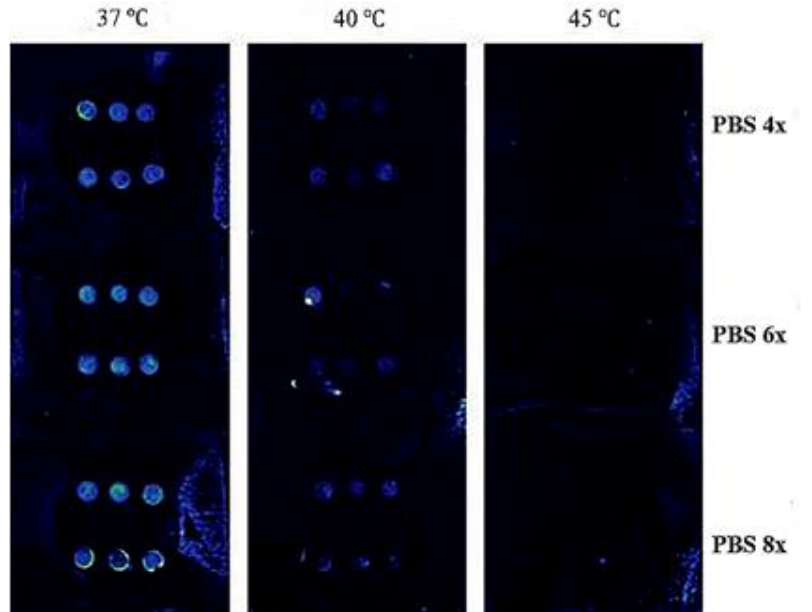
Figure 6. Inverted micrographs of HeLa cells grown in the absence and presence of the oligosiloxane modified thiophenes. Panels A and D are control after 18 h and 7 days, respectively. Panels B and E are poly(VI)-co-poly(3-methylthiophene) (50/50, w / w ), after 18 h and 7 days, respectively. Panels C and F are poly(VII)-co-poly(3-methylthiophene) (50/50, w / w ), after 18 h and 7 days, respectively.